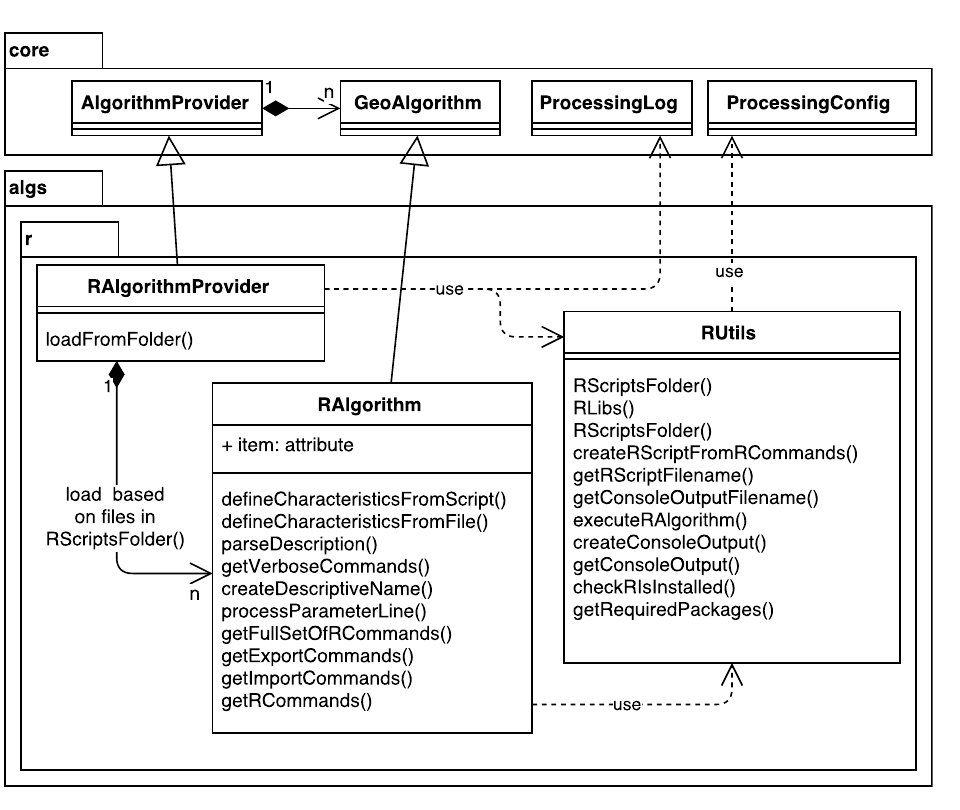
Figure 13. Class diagram of the R package and its connections to other